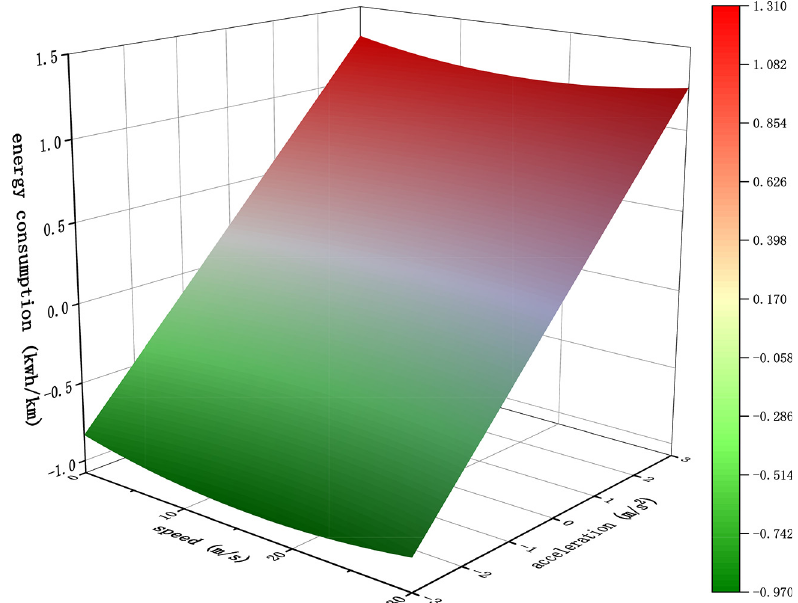
Figure 1 Energy consumption in unit kilometer mapping with speed and